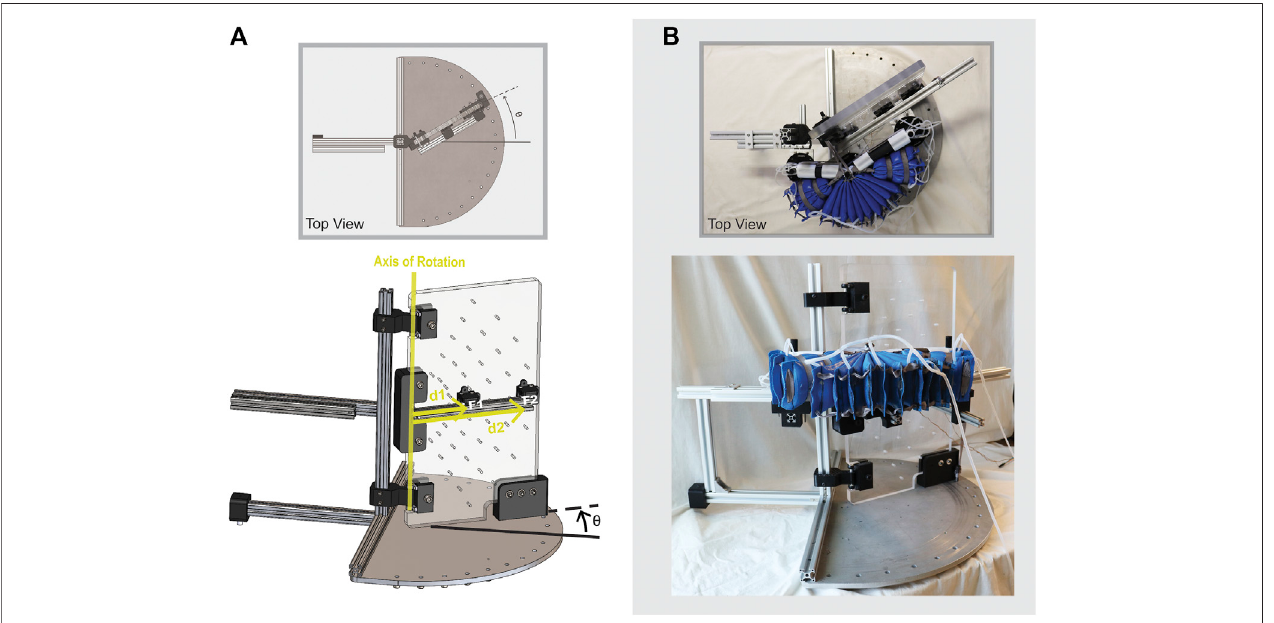
FIGURE 3 | Con fi guration to measure torque output of SWAG actuation system using custom torque measurement apparatus. Adjustable arm is rotated to set angle θ